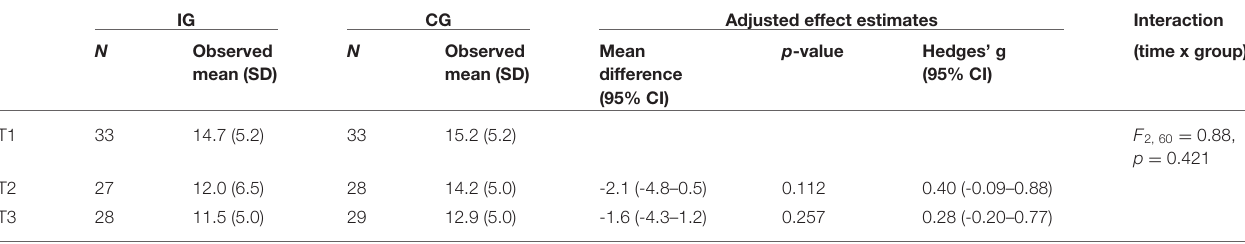
TABLE 3 | Results for the primary outcome measured by the Insomnia Severity Index (82). IG CG Adjusted effect estimates